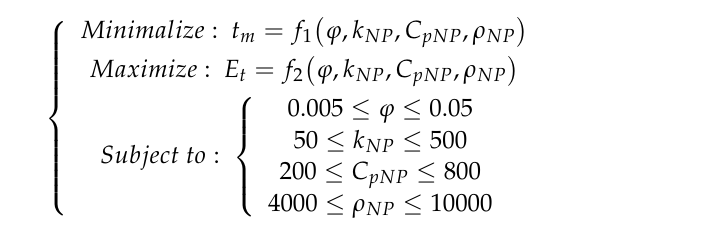
Figure 8. Schematics of multi-objective optimization process.